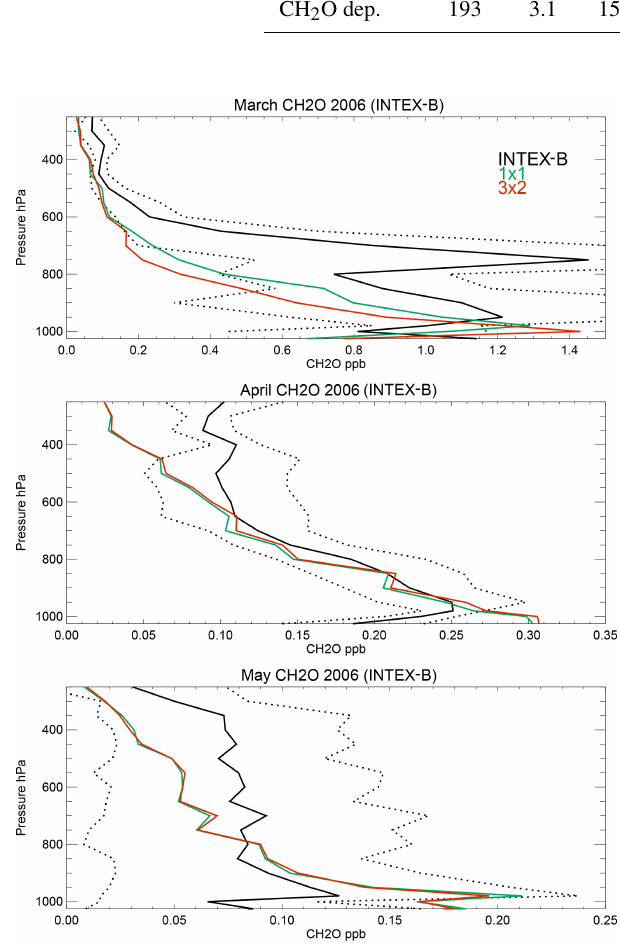
Figure 11. Comparisons of the vertical distribution of CH 2 O from both 3 ◦ × 2 ◦ and 1 ◦ × 1 ◦ simulations against measurements made as part of INTEX-B during 2006. The dotted line represents the 1 σ deviation in the mean of the measurements. For details on the exact location of the flights the reader is referred to Parrish et al.